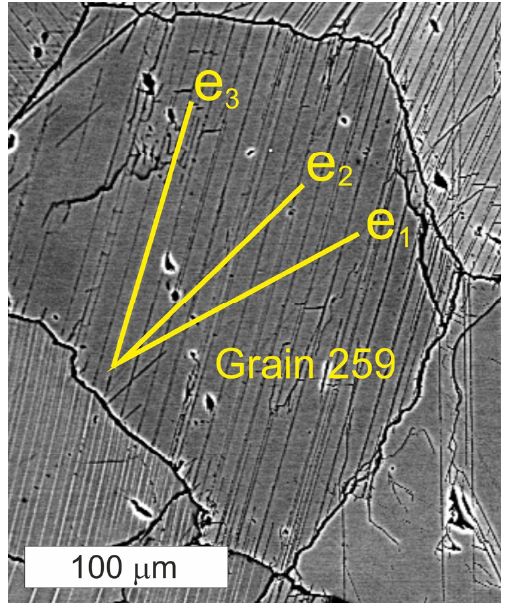
Figure 7. Orienting twin planes by trace analysis. Image of grain #259 (also shown in Figure 5) showing traces of one set of thin twin lamellae, together with the expected traces of the three possible twin planes ( e 1 , e 2 , e 3 ), the orientations of which were calculated from the host grain orientation. Trace e 3 corresponds to the orientation of the observed twin plane traces.